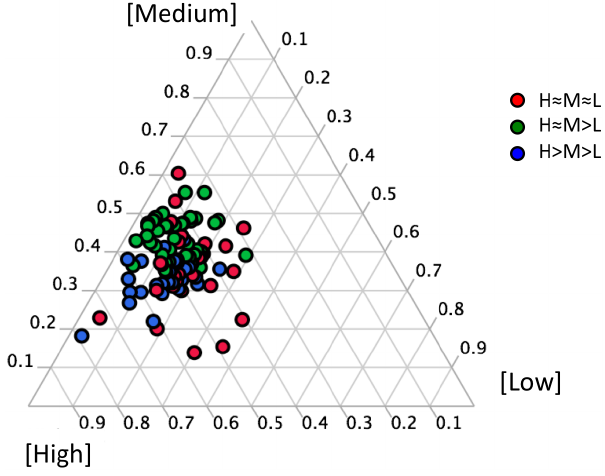
Figure 4. Ternary plot graphically depicting the ratios of the rRNA phylotype-specific incorporation to varying AA concen- trations added to SF Bay water. Data are color-coded according to the trophic strategies identified in Fig. 3. The position of each data point in relation to the three corners represents the relative contribution of each concentration